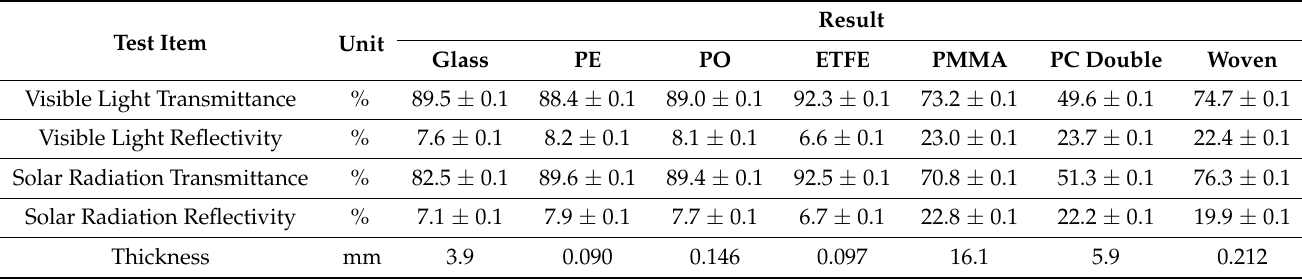
Table 7. Light performance test results of smart farm covering